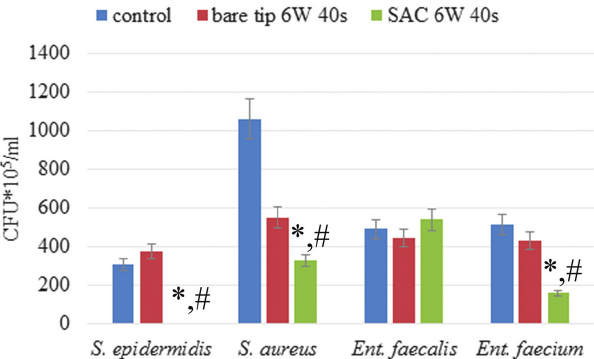
Fig. 2. The number of CFUs in S. epidermidis , S. aureus , Ent. faecalis , Ent. faecium suspension irradiated at 6 W for 40 s. *Data show signi¯cant di®erence compared with the control, p (cid:5) 0 : 05; # Data show signi¯cant di®erence compared with laser with a bare tip ¯ber, p (cid:5) 0 : 05.